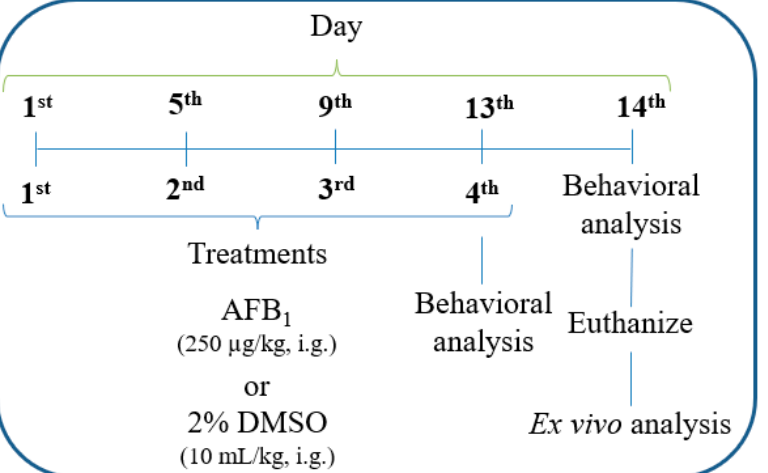
Figure 1. Schematic representation of the experimental design. Animals were divided into two groups (AFB 1 and DMSO) and treated with four doses separated by an interval of 96 h between each dose.